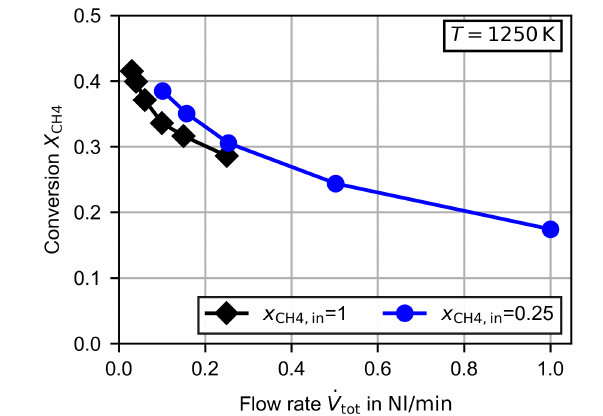
Figure 4. Measured methane conversion dependent on the total flow rate for pure methane and 25mol.% methane diluted in nitrogen at 1250K. Table 1. Overall reaction rates and average molar concentrations for the experiments presented in Figure 4. The molar concentrations were calculated by recalculating the experiments with a plug flow reactor model. ˙ V tot in